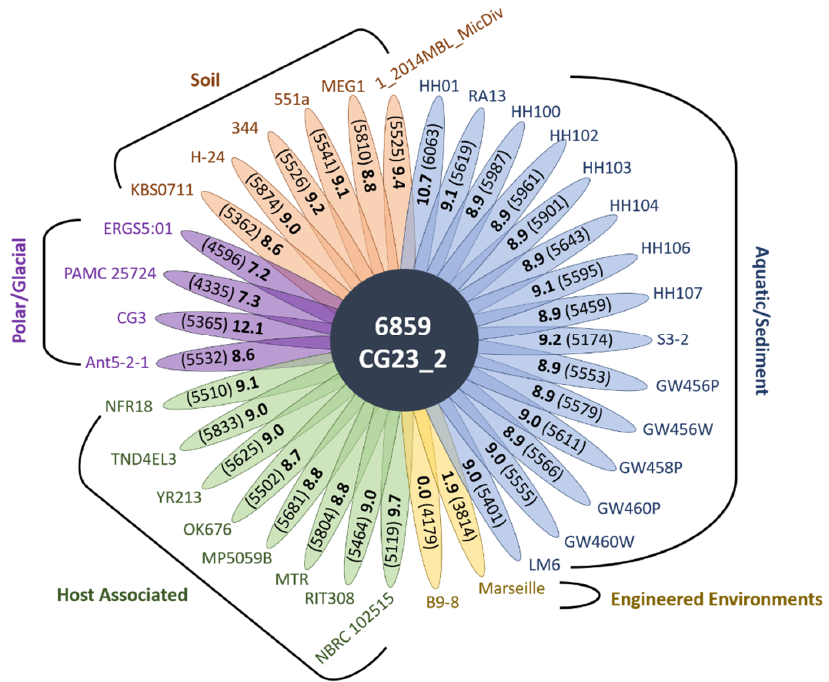
Figure 2. Pairwise gene comparison between Janthinobacterium sp. CG23_2 and the 35 Janthinobacterium spp. with a 90% query coverage and an 80% identity. The total number of genes from CG23_2 is in the figure center. Each petal depicts the percentage of shared genes (bold) and the total number of predicted protein coding sequences (in parentheses) for each strain.